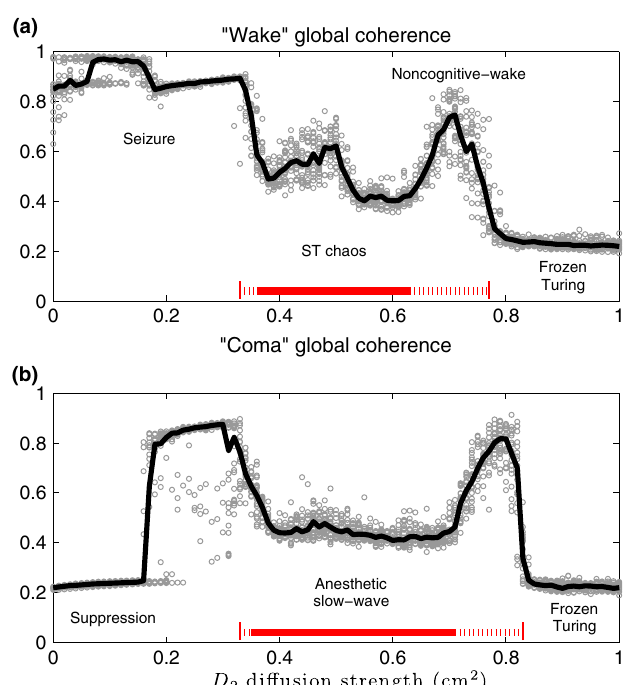
FIG. 7. Phase coherence trends for a two-point-connected cor- tex. Spatially averaged phase coherence measurements for (a) high-firing wake ( (cid:13) i ¼ 1 : 00 ) and (b) low-firing coma ( (cid:13) i ¼ 1 : 018 ) states of the noise-driven cortex for default two-point connectivity strength ( (cid:12) ¼ 200 ) are shown. Gray circles repre- sent the outcomes of 20-s noise-stimulated numerical experi- ments at a given value of inhibitory diffusion in the range 0.0 to 1 : 0 cm 2 in steps of 0.01 cm; simulations were repeated 20 times at each D 2 value for a total of 2020 data points per panel. For each experiment, we computed the R ð x 0 ; x Þ coherence matrix for the final 2 s of the space-time record [e.g., see Figs. 5(b) and 6(b)], then extracted its upper-triangular matrix mean as an estimate of global phase coherence. Bold-black curves show the data median to guide the eye. Solid- (striped-) red bars indicate regions of a strongly (weakly) positive Lyapunov exponent as extracted from paired noise-free simulation